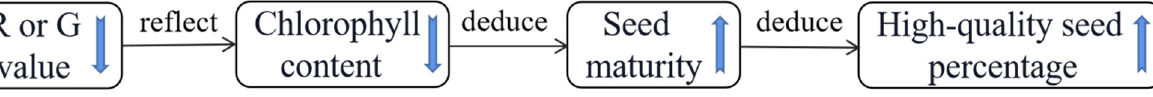
Figure 10. The relation between the maturity and G or R values.